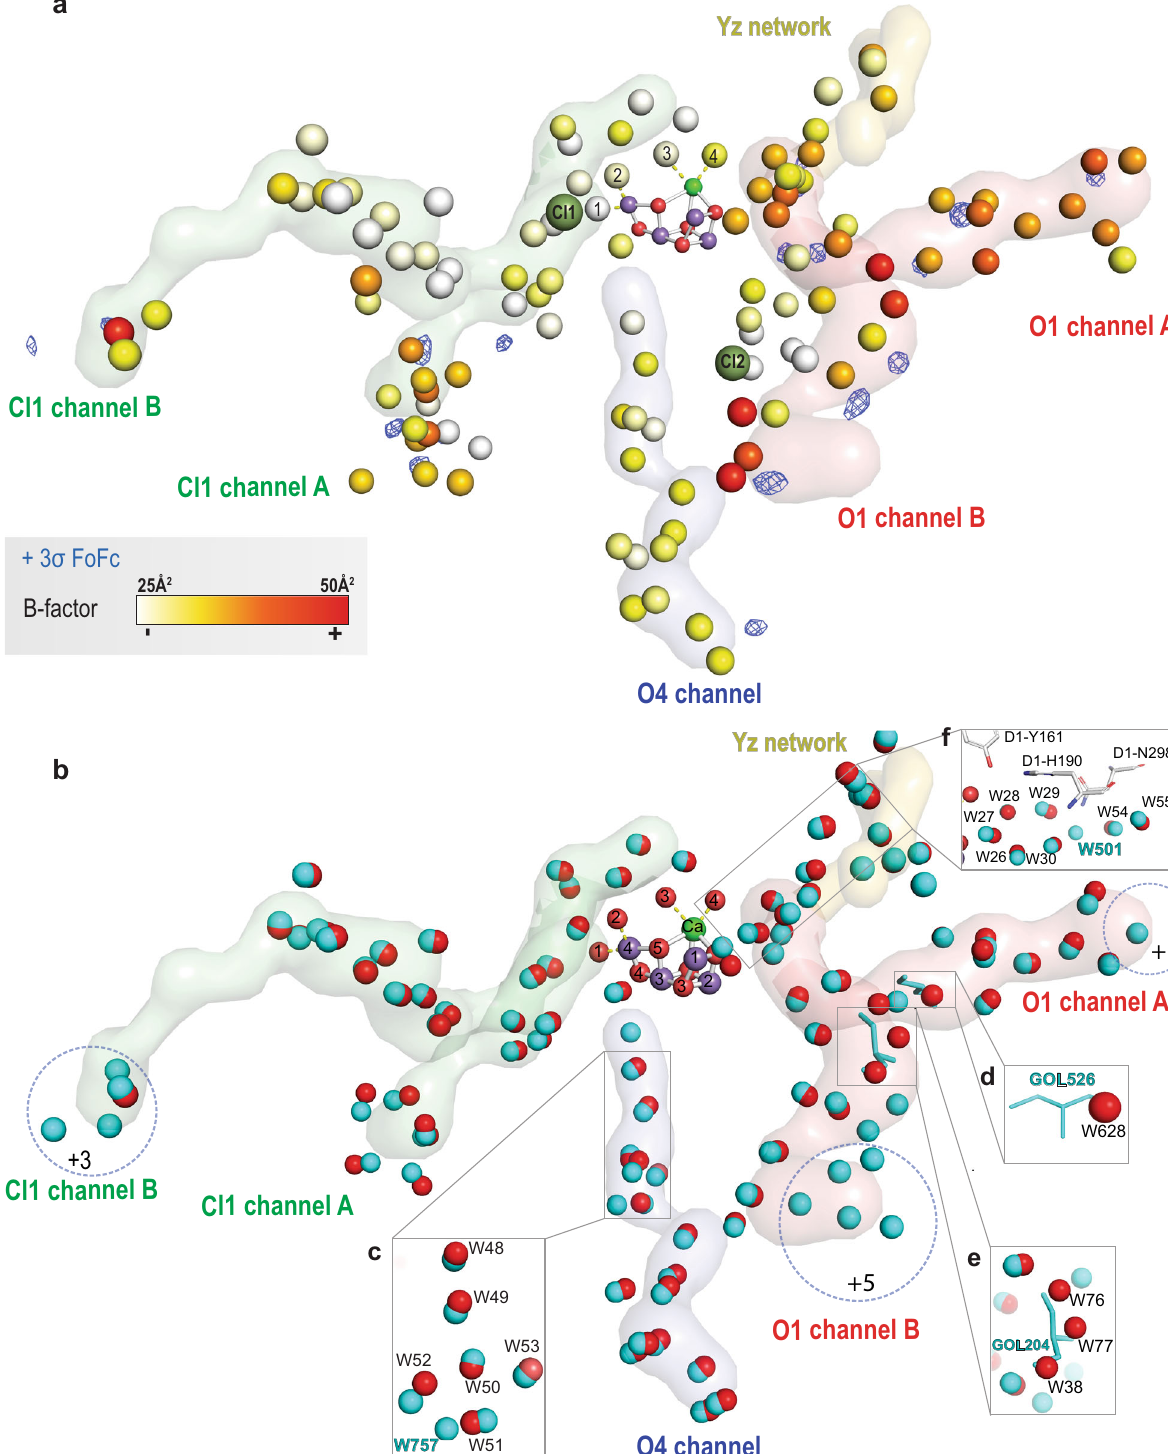
Fig. 2 Water channels in the 1.89 Å resolution RT structure. a Fo-Fc, electron density omit map, contoured at ≥ + 3 σ in blue for all the proposed water channels. The water molecules are represented using a color gradient scale, representing the B-factor of each water (white color for B-factor 25 to red color for B-factor 50). The channels and the network, O1 Channel in red, O4 Channel in blue, Cl1 Channel in green, and Yz network in yellow. b Comparison between water channels in the RT and cryo structures. The water molecules detected within 3.5 Å from the water channels in red for the 1.89 Å RT structure (PDB ID: 7RF1) and cyan for the 1.95 Å cryo structure (PDB ID: 4UB6). Extra water molecules in the 1.95 Å cryo structure (PDB ID: 4UB6) detected within 5 Å away from the bulk are highlighted in blue circles. A comparison of the structural differences present in the O4 channel, O1 channel A and O1 channel B between the 1.89 Å RT structure (colored in red and labeled in black) and the 1.95 Å cryo structure (PDB ID: 4UB6) (colored in cyan and labeled in cyan) are shown in ( c ), ( d ), and ( e ), respectively. f Structural differences in waters of the Yz network between 1.89 Å RT structure (colored in red and labeled in black) and the cryo structure with PDB ID: 6JLJ (colored and labeled in